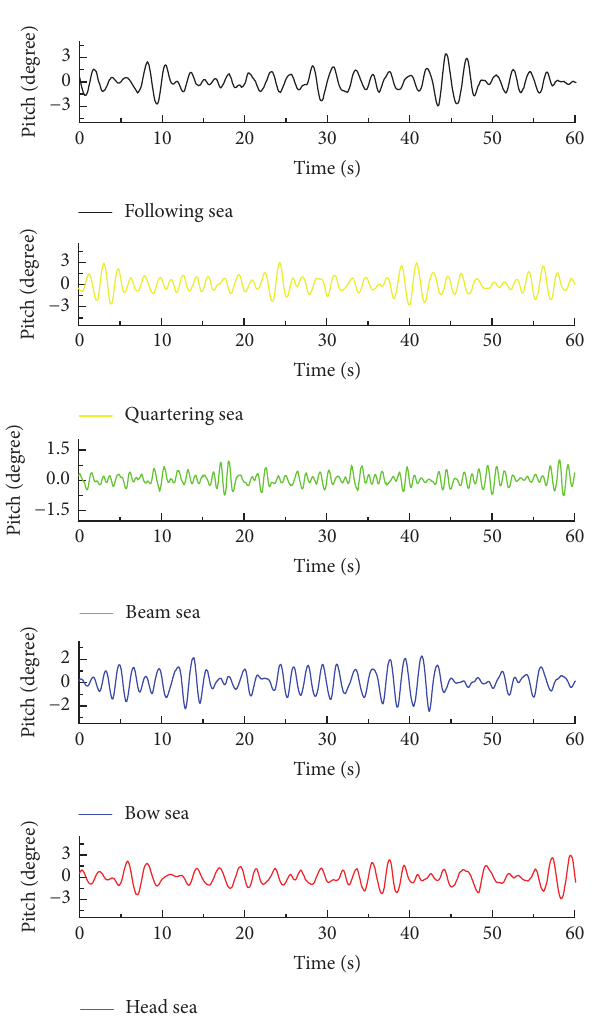
Figure 13: Time histories of pitch in irregular waves.